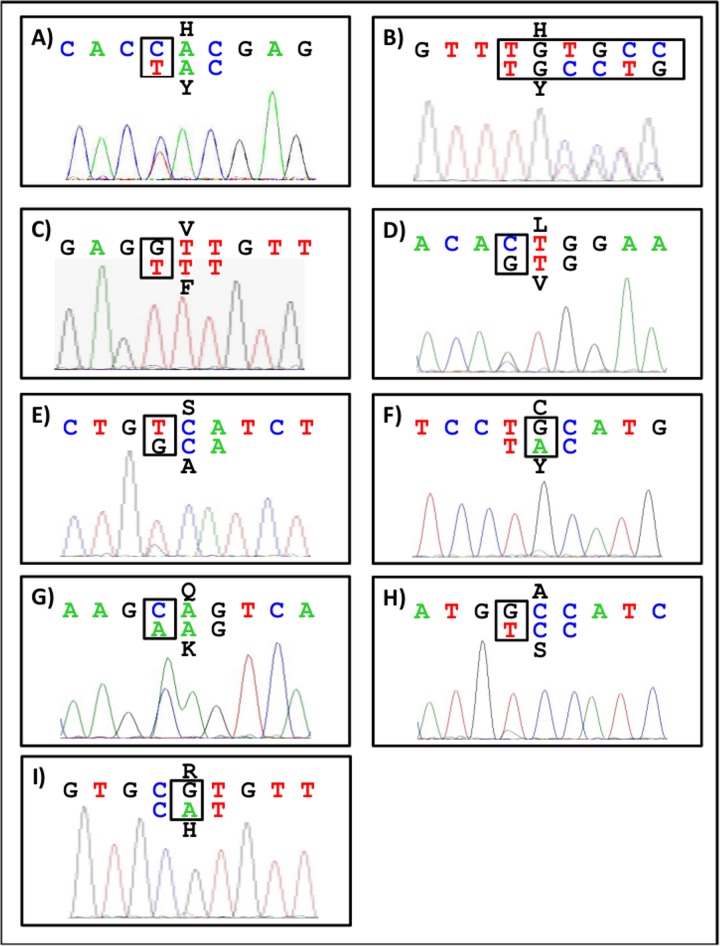
Representative electropherograms of TP53 mutated GIST samples.TP53 mutations were detected by Sanger sequencing. Representative electropherograms are shown for each TP53 mutated sample (A-I) in the same order as shown in Table 1. Six mutations resulted in a non-functional p53 (A-D, F, I), two mutations resulted in a partially functional p53 (G-H) and one mutation could be detected without influence on the p53 function (E).